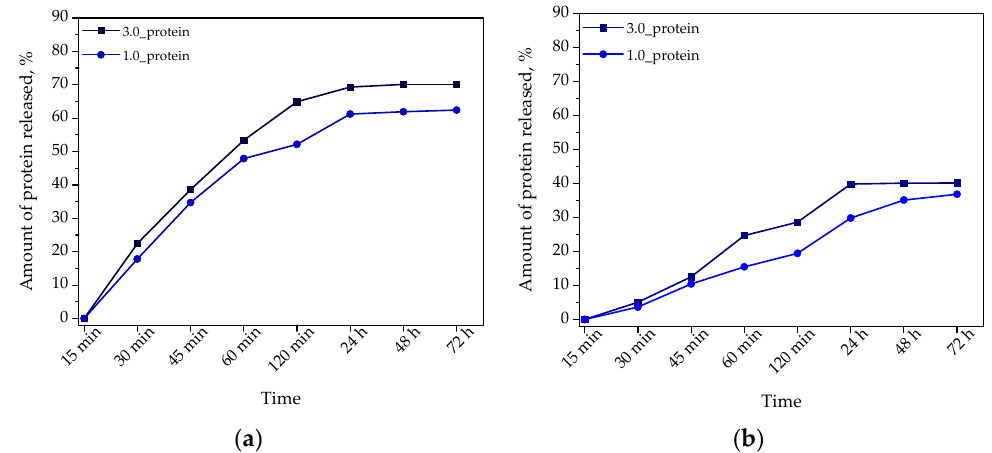
Figure 11. Results of the protein release from hydrogels in the environment with pH = 2.0 ( a ) and pH = 7.4 ( b ). pH = 7.4 ( b